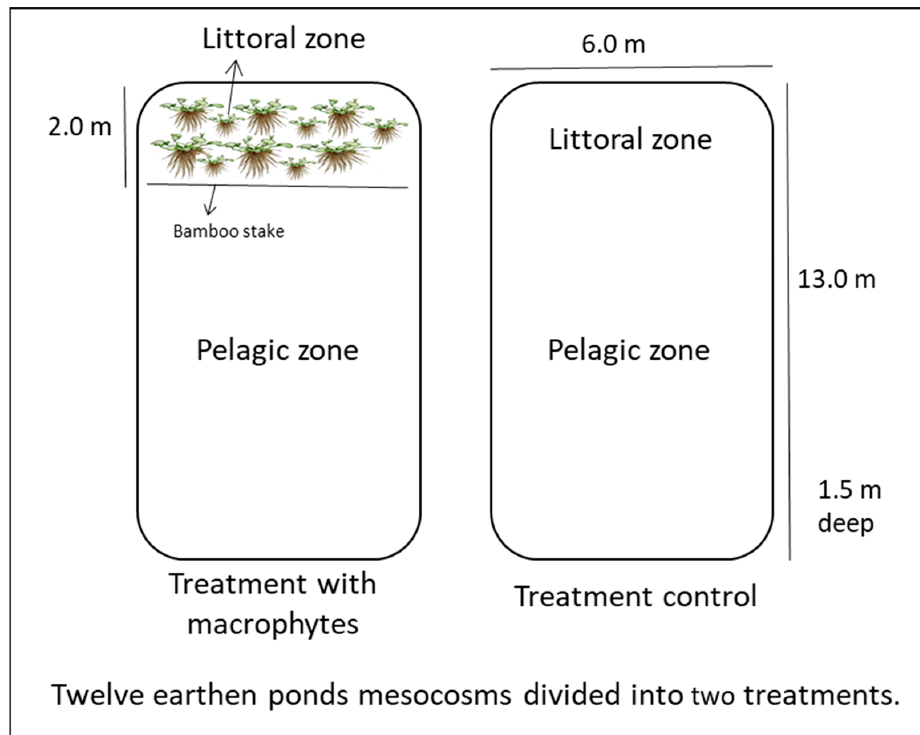
Figure 1. Schematic of the experimental design indicating both treatment and zone of sampling in the mesocosms.